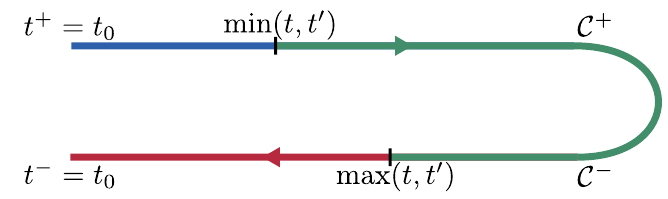
Figure 2: Expanding the contour-ordered Green function G ( t , t (cid:48) )